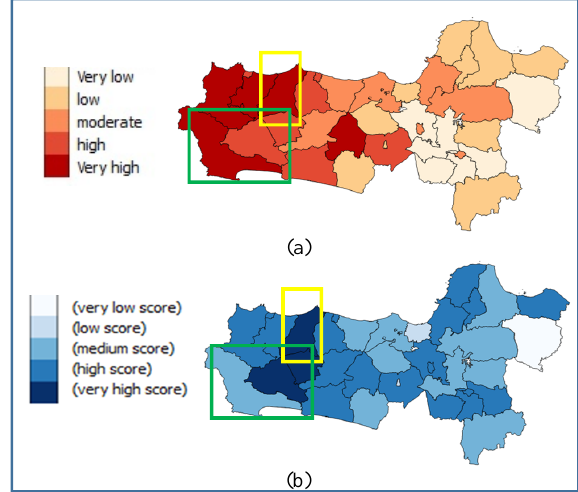
Figure 4. The results of a social vulnerability index; (a).